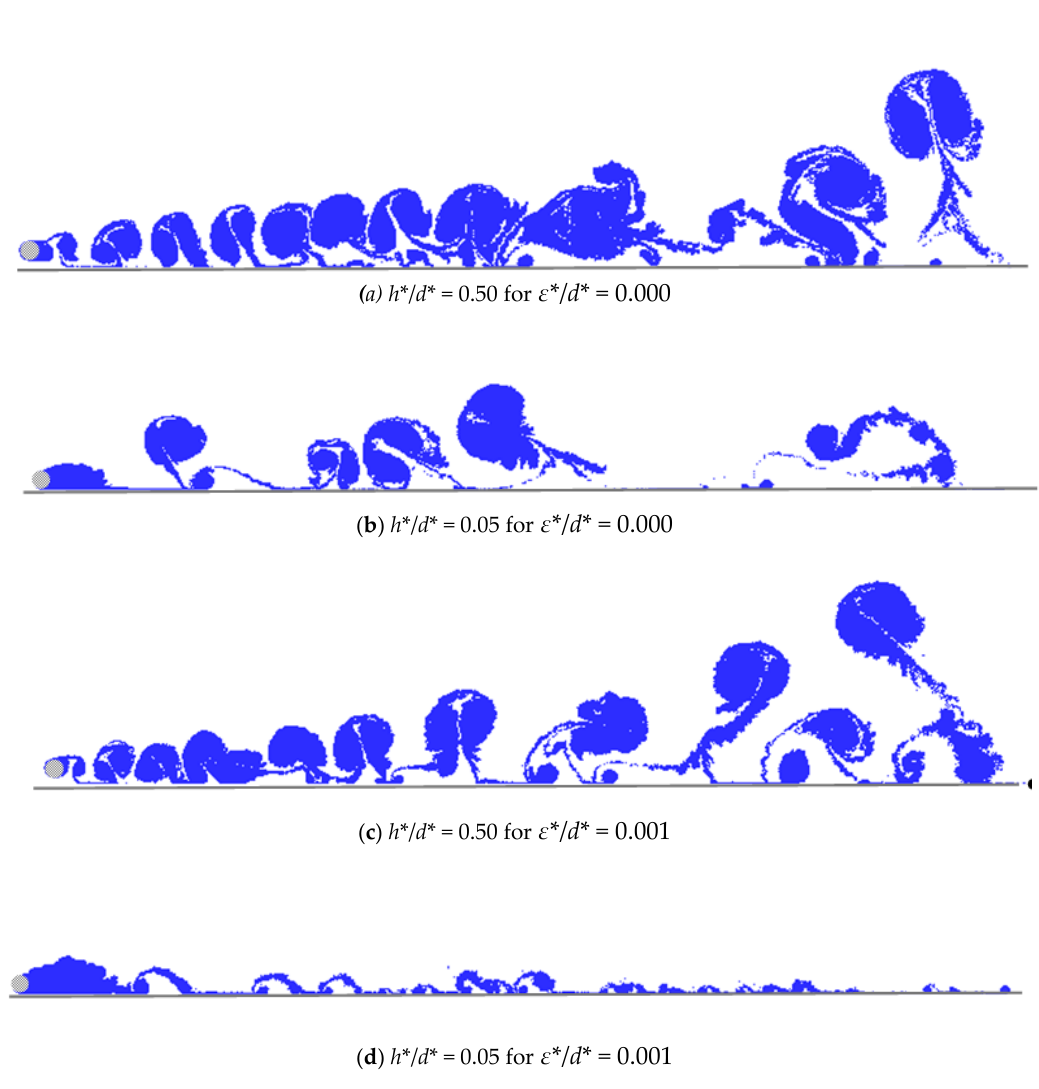
Figure 8. Final positions of clusters of vortex blobs for the circular cylinder in the vicinity of a moving wall at t = 75 ( Re = 1.0 × 10 5 ).